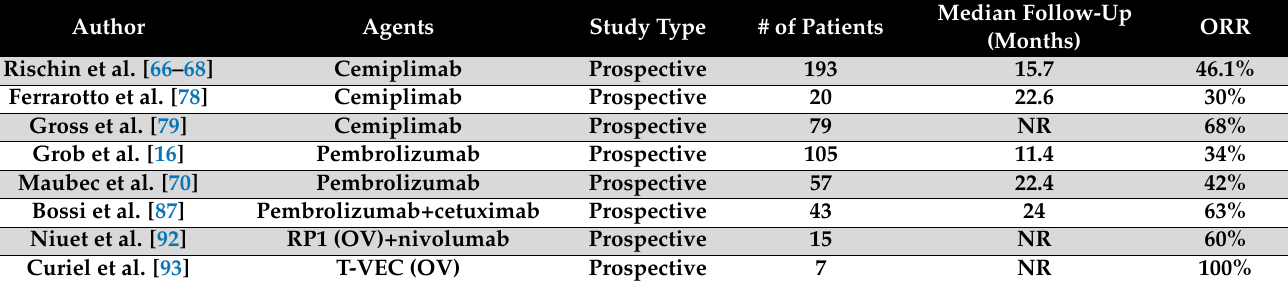
Table 2. Immunotherapy Agents with Activity in